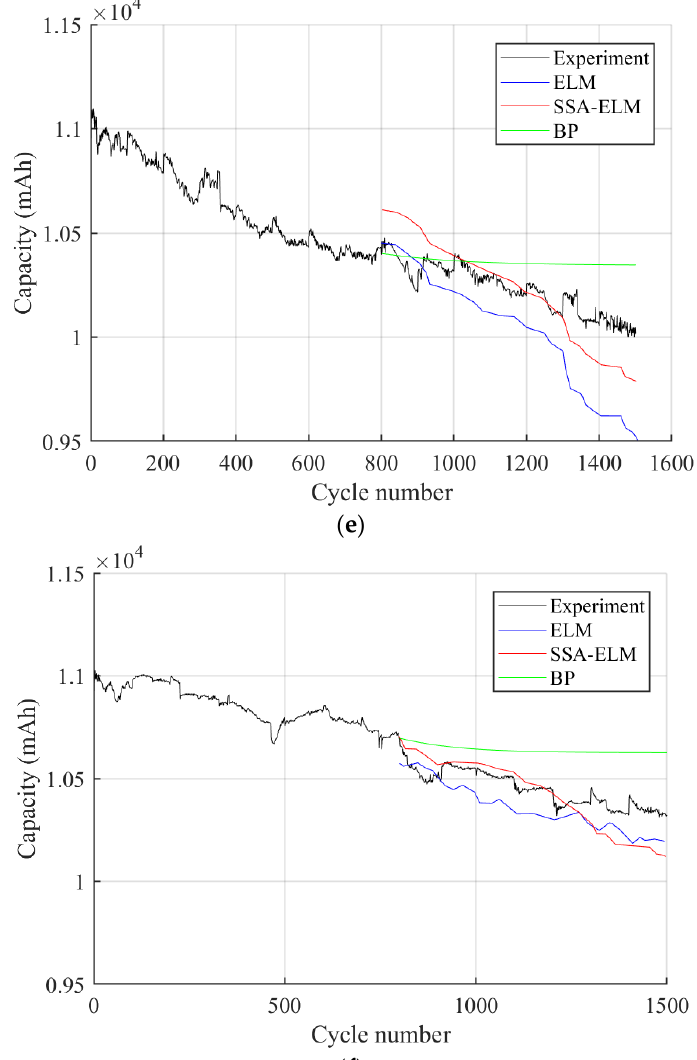
Figure 6. Comparison of prediction results of six cells. ( a ) Comparison of the prediction results of battery 1. ( b ) Comparison of the prediction results of battery 2. ( c ) Comparison of the prediction results of battery 3. ( d ) Comparison of the prediction results of battery 4. ( e ) Comparison of the prediction results of battery 5. ( f ) Comparison of the prediction results of battery 6.